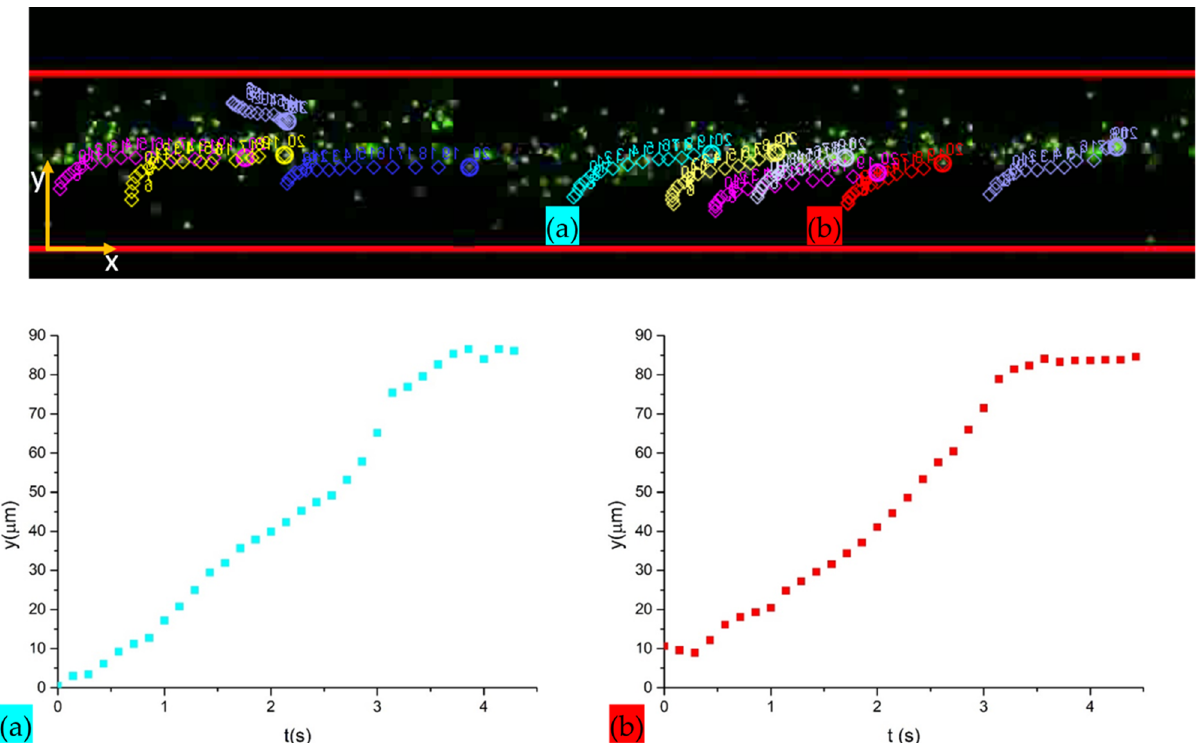
Figure 9. Tracking of bead paths with the Tracker 2.6 software and measurement of the transverse path y ( t ) from channel walls to the pressure node of two different beads ( a ) and ( b ). Measurements were performed in a specific focal plane of the 4× objective lens of the fluorescence microscope.